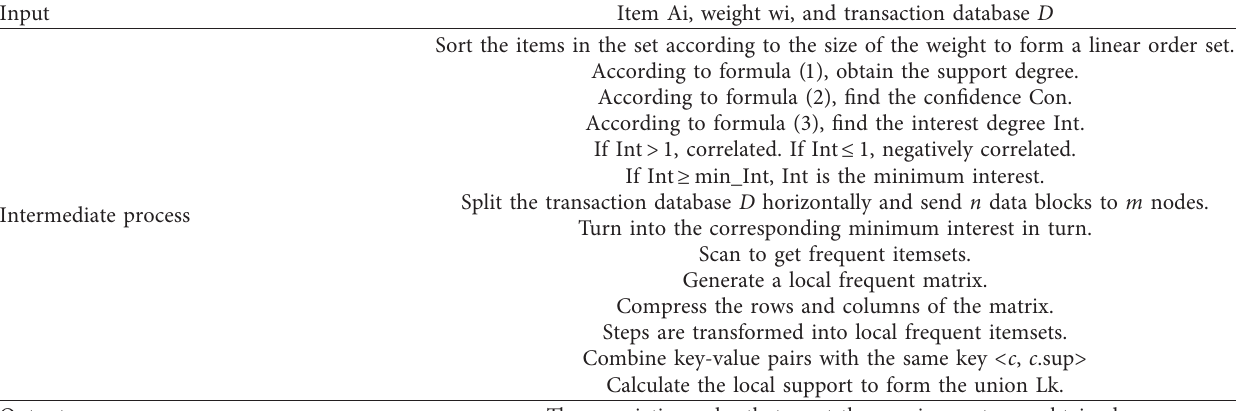
Figure 4: Data mining process. Table 3: The pseudocode of the